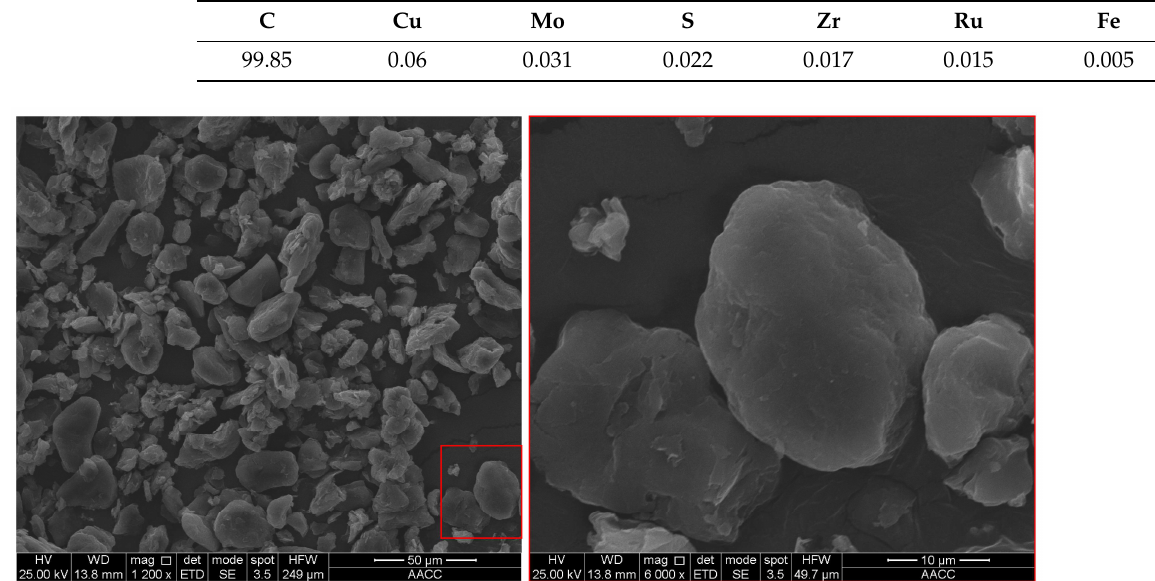
Figure 13. SEM-EDS result of the liberated graphite electrode material.